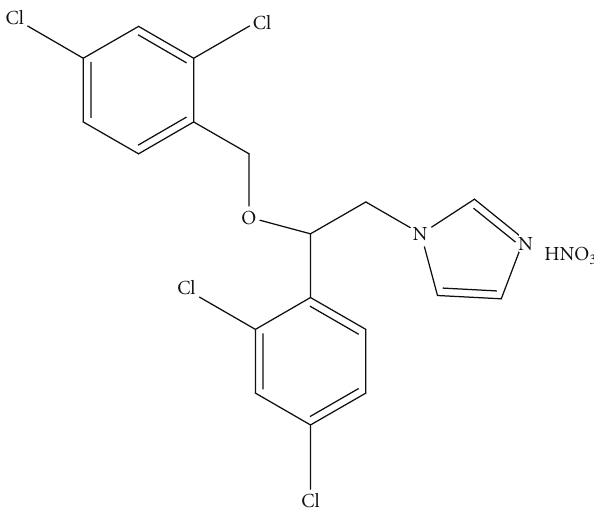
Figure 1: Molecular structure of miconazole nitrate inhibitor.